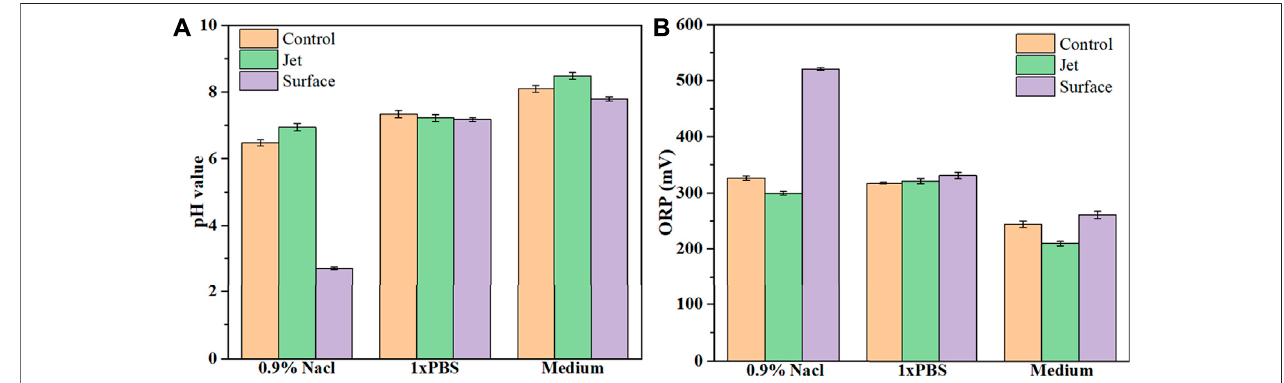
FIGURE 3 | Values of pH (A) and ORP (B) in control, plasma jet- and surface-treated 0.9% NaCl solution, PBS, and 1,640 medium. Solutions were treated by the plasma jet or surface devices for 3 min.